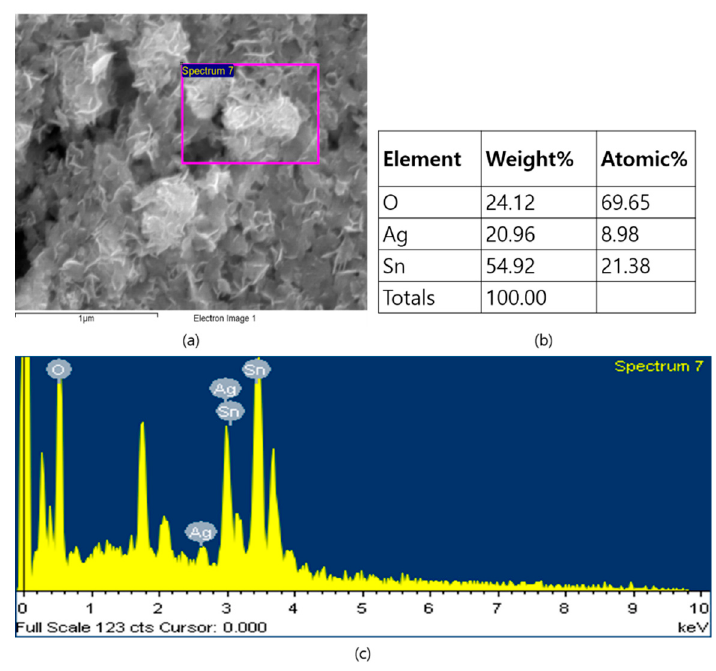
Figure 4. EDX spectrum of the Ag QDs/SnO 2 nanostructures: ( a ) SEM image; ( b ) EDX data of Ag QDs / SnO 2 nanostructures; ( c ) EDX spectrum of Ag QDs / SnO 2 nanostructures.